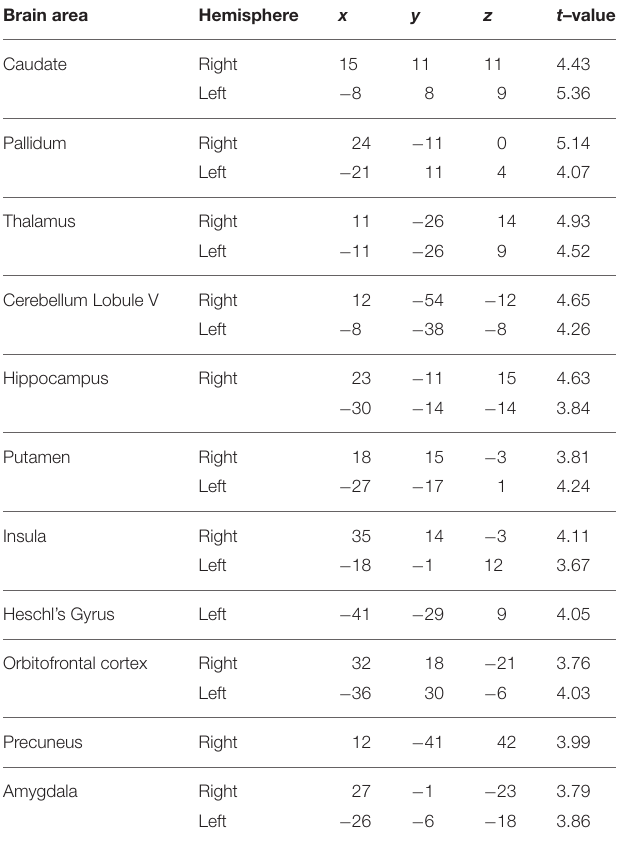
Table 3A | Brain areas activated for jitter vs. number-of-intervals condition. Brain area